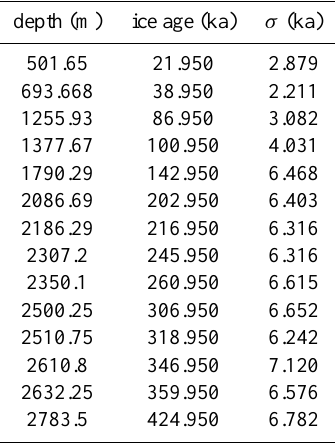
Table 4. Orbital ages from air content for EDC, deduced from Raynaud et al. (2007).